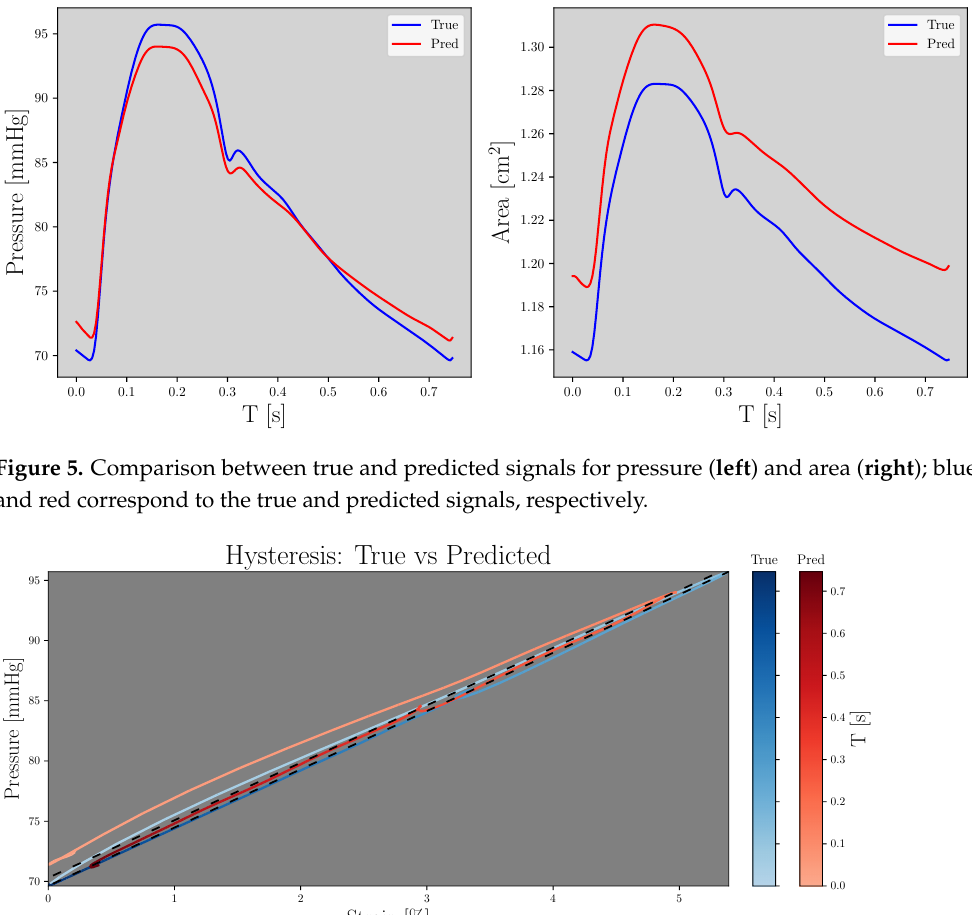
β from Equation (10). (cid:98)